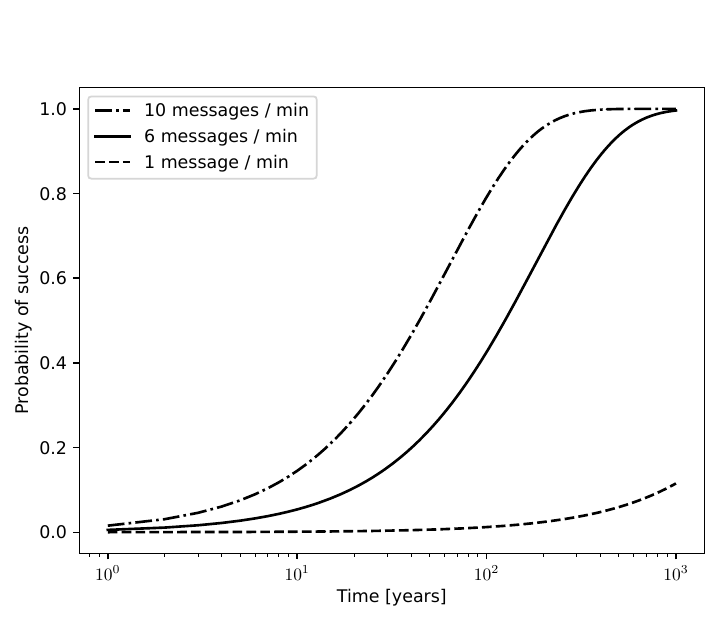
Figure 8: Probability of finding three pairs with good differences in plaintexts, ciphertexts and tweaks as a function of time in a best-case